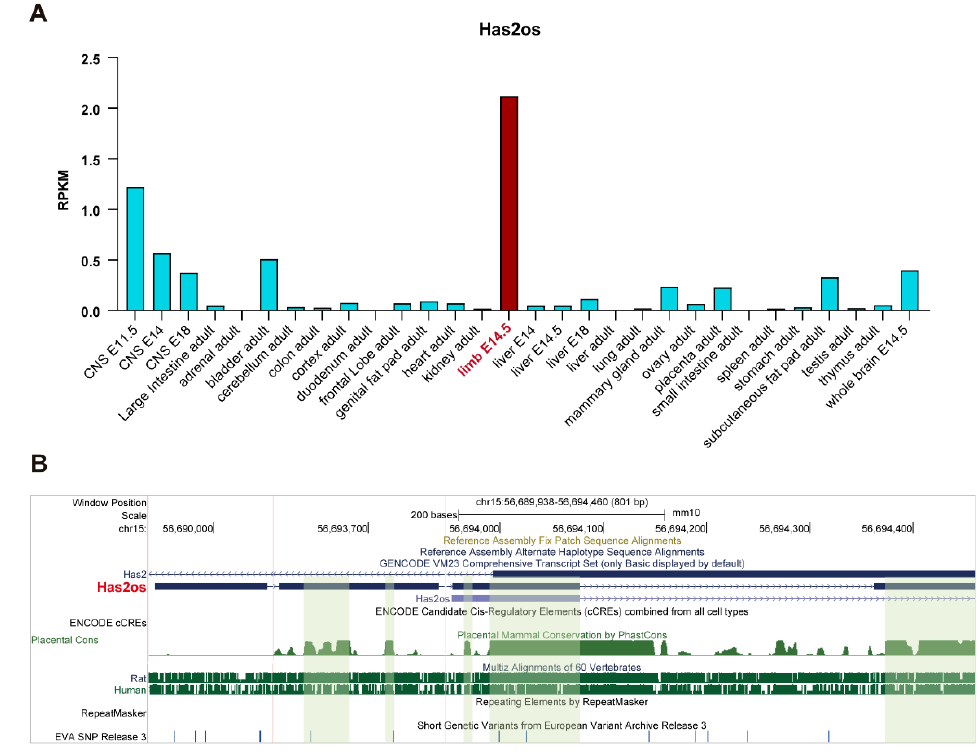
Figure 1. lncRNA Has2os was highly expressed in skeletal muscle. ( A ). lncRNA Has2os was signif- icantly highly expressed in skeletal muscle. Vertical coordinate is RPKM (reads per kilobase of tran- script per million reads mapped). Data were obtained from the NCBI database (https://www.ncbi.nlm.nih.gov, Accessed on 12 February 2022). ( B ). lncRNA Has2os is harbored in the Has2 gene, and conserved across multiple vertebrate species especially in human and mice. Data were obtained from UCSC genome browser (http://www.genome.ucsc.edu, Accessed on 15 October